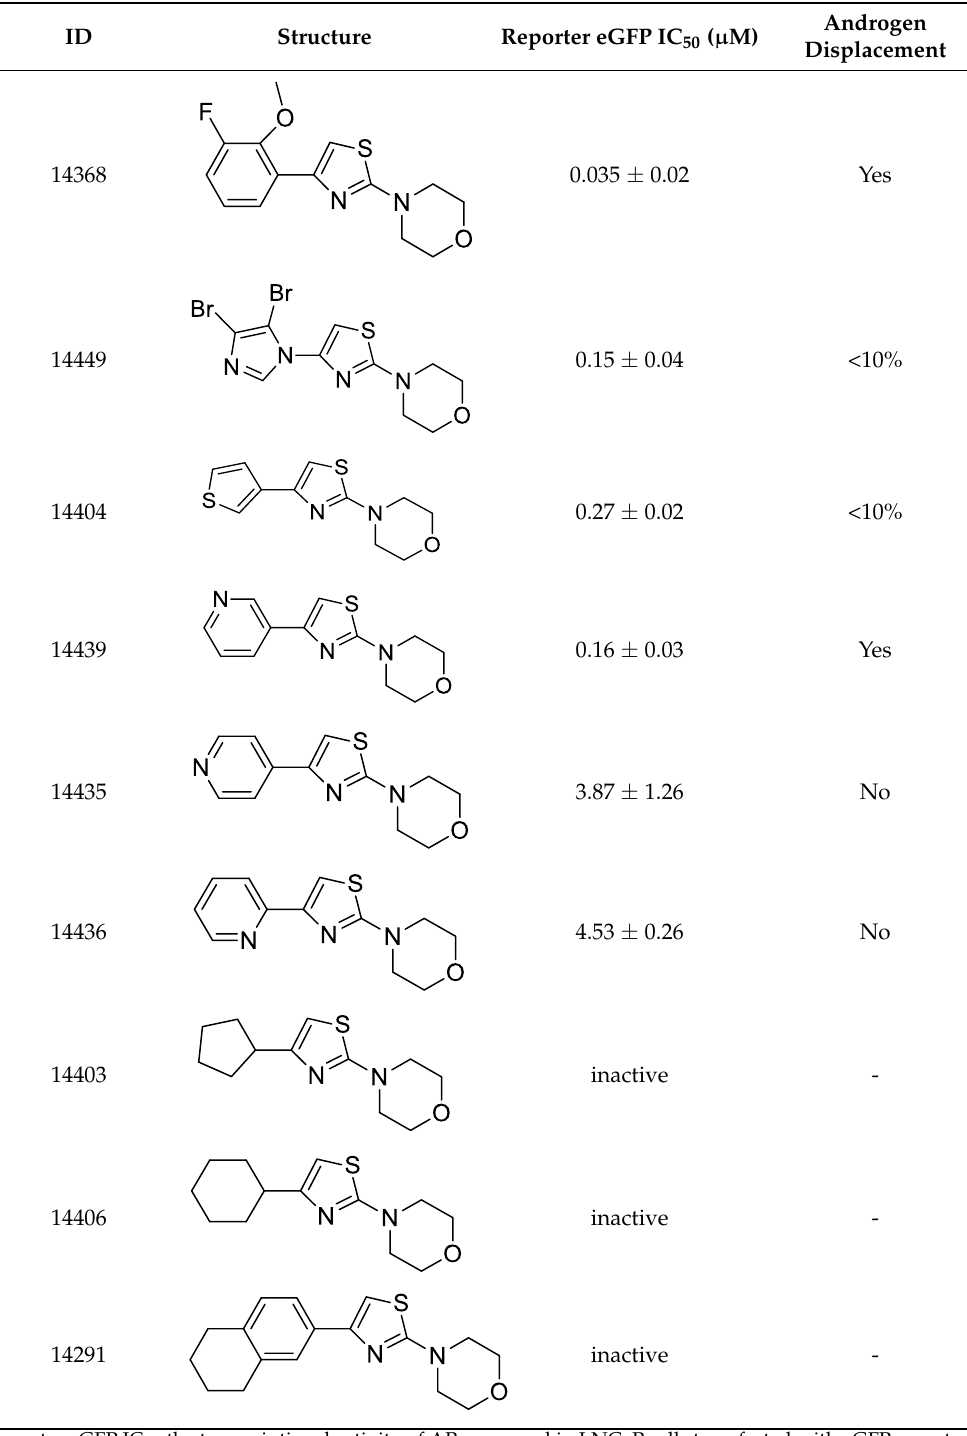
Table 1. Structure and activity profiles of 4-(4-(3-fluoro-2-methoxyphenyl)thiazol-2-yl)morpholine derivatives.